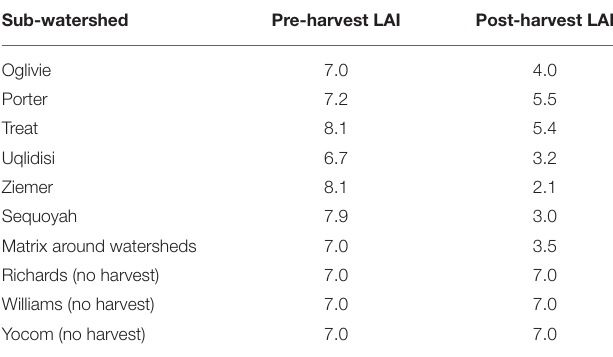
TABLE 4 | Leaf Area Index used in DHSVM simulations of the planned Phase III Harvest of the South Fork of Caspar